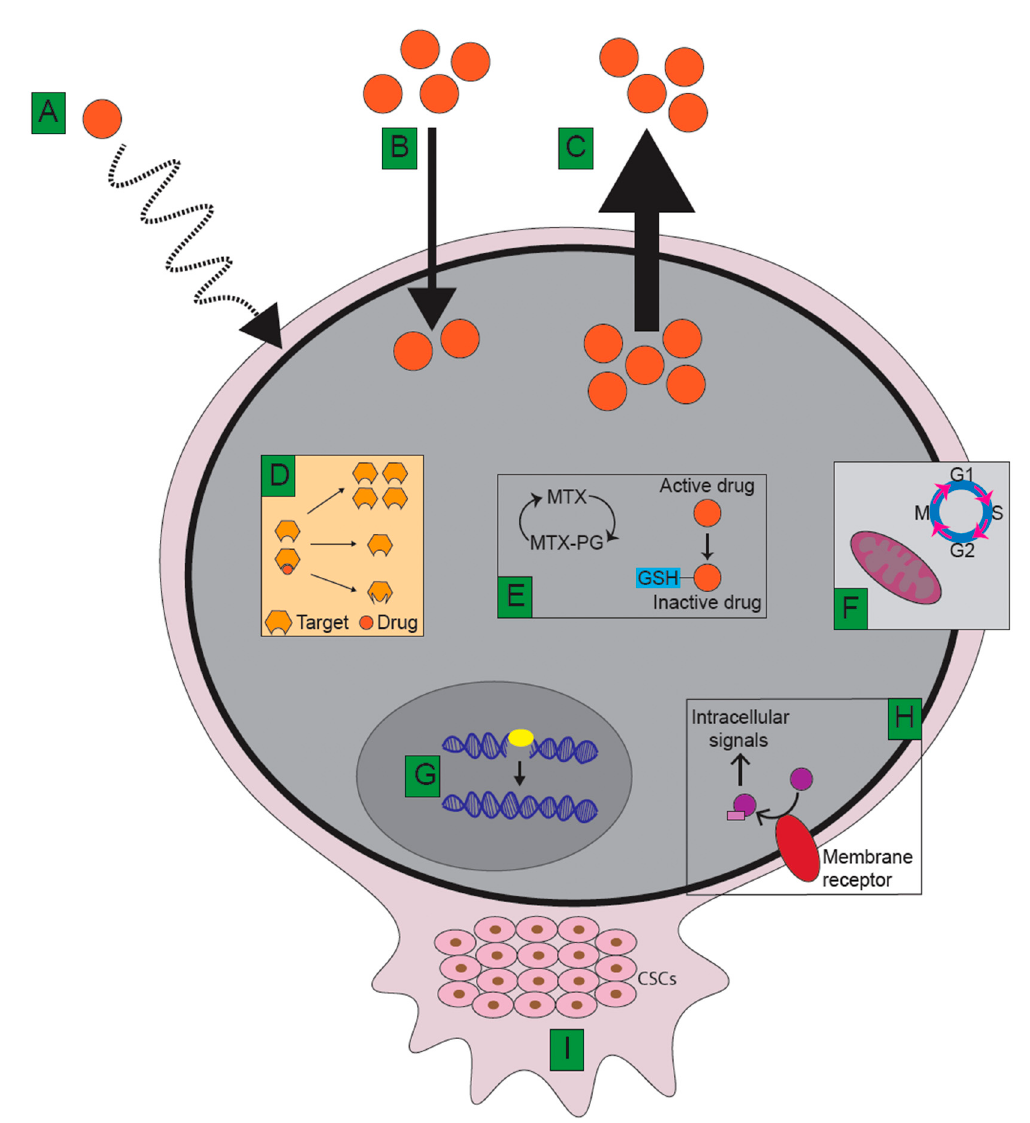
Figure 2. Major mechanisms contributing to therapy resistance in an osteosarcoma tumour cell. ( A ) Inefficient drug delivery and/or penetration. ( B ) Reduced drug influx due to alterations to drug carriers such as the reduced folate carrier. ( C ) Increased drug efflux due to upregulated ATP-binding cassette (ABC)-family transporters. (D) Reduced affinity of drug to its target due to target overexpression, repression, or mutations at the interaction site. ( E ) Reduced accumulation due to intracellular drug modifications such as changes in the polyglutamylation (PG) of methotrexate (MTX) or conjugation with glutathione (GSH). ( F ) Perturbations in apoptosis and cell cycle regulation. ( G ) Alterations in DNA repair pathways. ( H ) Altered signal transduction. ( I ) Cancer stem cells (CSCs) and tumour microenvironment.